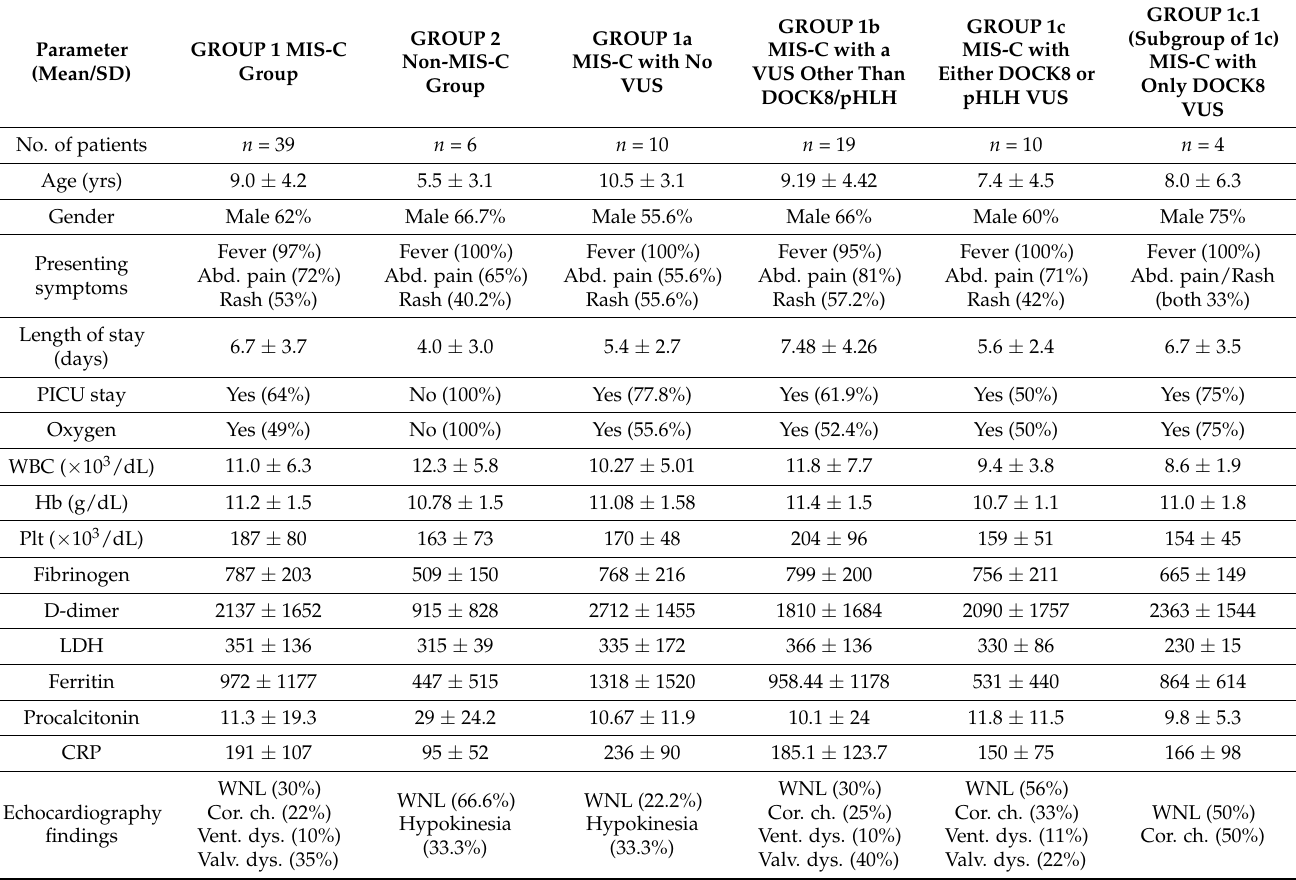
Table 1. Clinical characteristics of MIS-C patients and controls with and without immune dysfunction gene